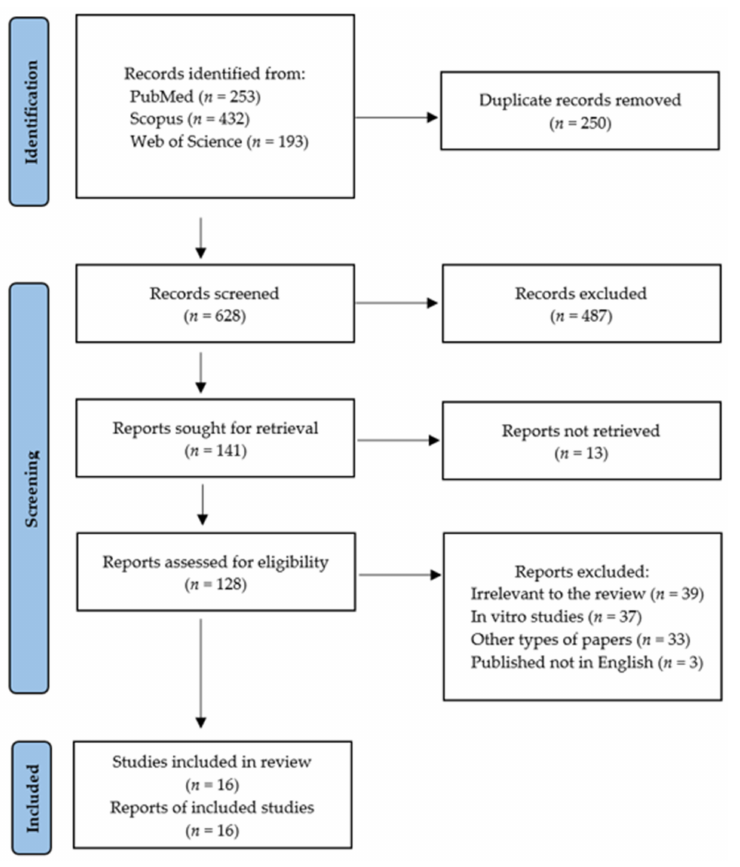
Figure 2. PRISMA flow diagram presenting search strategy. Table 2. General characteristics of included